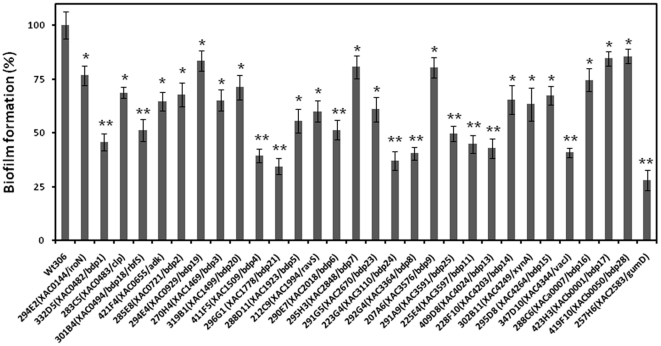
Quantitative biofilm assay in borosilicate glass tubes showing the ability to form biofilm by a proportion of the EZ-Tn5 mutants of Xanthomonas axonopodis pv. citri strain 306.The biofilm was determined using crystal violet staining coupled with measurements of absorbance at 590 nm (A590). The experiment was repeated three times with five replicates. Averages and standard errors from one of three representative experiments with similar results are shown. Wild-type strain 306 was set as equal to 100%. Statistical significance was tested by Student's t-test (* indicates significant differences from wild-type strain 306 at P<0.01; ** indicates significant differences from wild-type strain 306 at P<0.001).